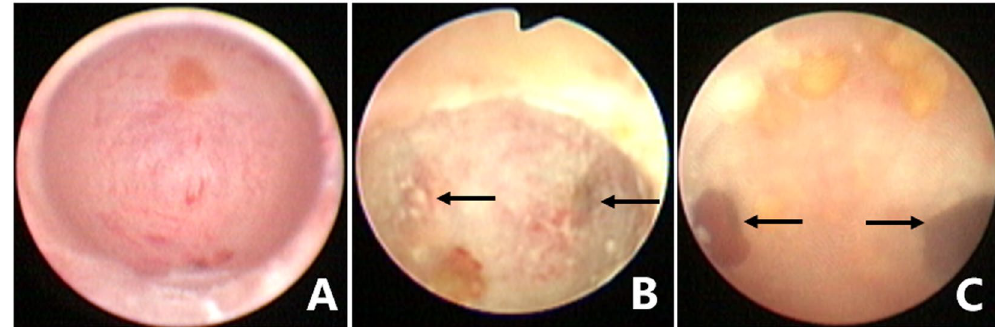
Figure 7. Different patterns under endoscopic observation in the PU. ( A ) The normal oval inner morphology of PU in some patients. ( B ) A pair of symmetrical translucent membranous weak areas was found at the 4 and 8 o’clock positions on the posterolateral wall of the PU in some patients. A small stone was also observed in the PU. ( C ) Bilateral ectopic passages of the EDs were observed at the 4 and 8 o’clock positions of the posterolateral wall of the PU in pathological conditions. Some small stones were observed in the